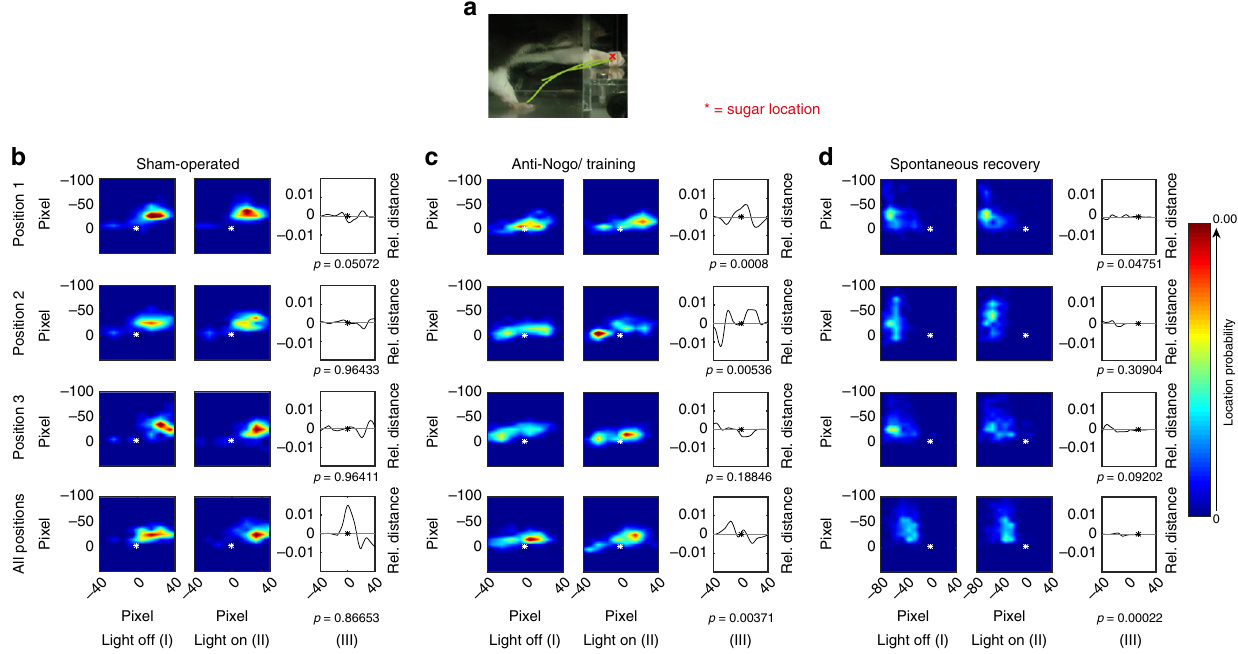
Fig. 6 Animals with excellent motor recovery show speci fi c regional organization of distinct microcircuitry in the contralesional cortex for the targeting kinematics of skilled grasping. a Side view (cutout) of a rat performing single pellet grasping. The paw trajectory of a successful grasp is superimposed. The furthest extension of the paw, location x , was automatically detected to capture the grasping trajectory in relation to the position of the sugar pellet. b – d Spatial distribution of the furthest extension calculated using every grasping trial under “ light-off ” (I) and “ light-on ” (II) conditions; (III) relative distance between “ light-off ” and “ light-on ” (* = position of the sugar pellet). Therefore, the spatial distribution (I) and (II) are marginalized onto the x -location, before subtracting the resulting one-dimensional distributions to obtain (III). b Targeting of the paw to its fi nal position over the sugar pellet in “ sham-operated ” animals was unaffected by light stimulation at positions 1 – 3 of the sensorimotor cortex independently or by concurrent light exposure of all cortical positions ( “ all positions ” : positions 1 – 3 together). c Animals of the “ Anti-Nogo/Training ” group with excellent recovery of grasping reached too far when the recrossed corticospinal neurons were inhibited in the contralesional premotor cortex position 1 or too short when the neurons in M1 (pos. 2) were silenced, whereas silencing close to S1 (Fig. 5d, pos. 3) did not affect the grasping behavior under “ light-on ” conditions. d Paw targeting of the “ Spontaneous recovery ” animals was poor overall and only signi fi cantly altered when all three cortical positions were optogenetically silenced at the